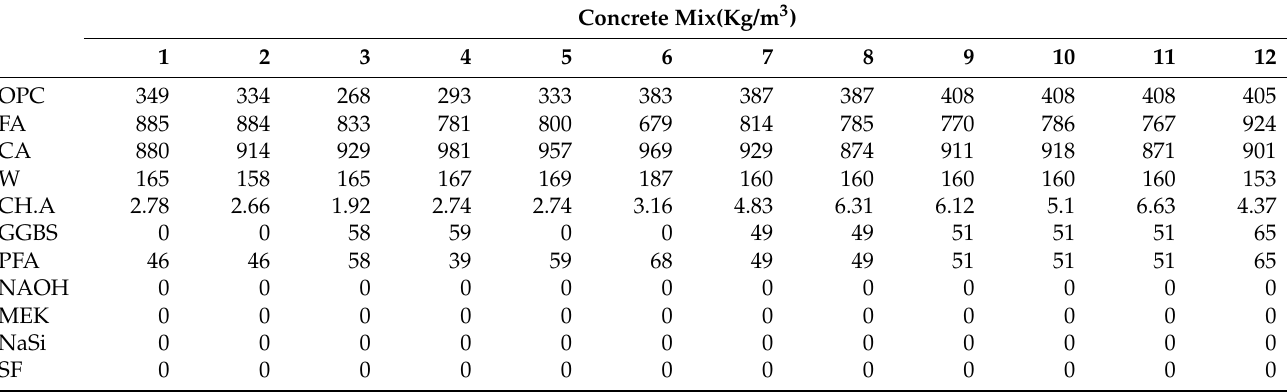
Table 14. Concrete mix optimisation extracted from Concrete Batch C